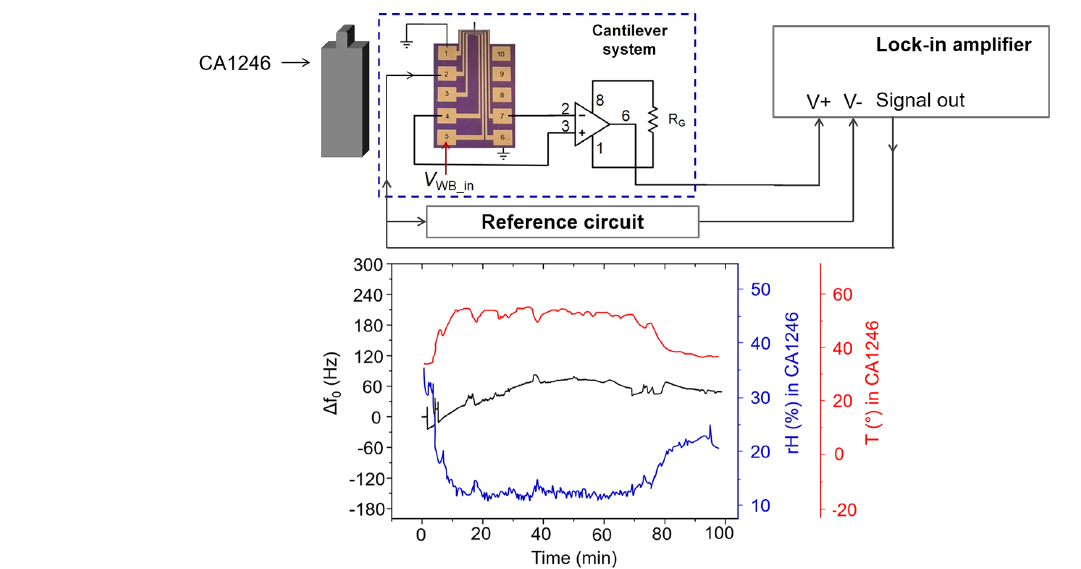
Figure 11. Resonant frequency shift ( (cid:49)f 0 ) of a piezoresistive silicon cantilever under exposure of outdoor temperature ( T ) and relative humidity (RH).